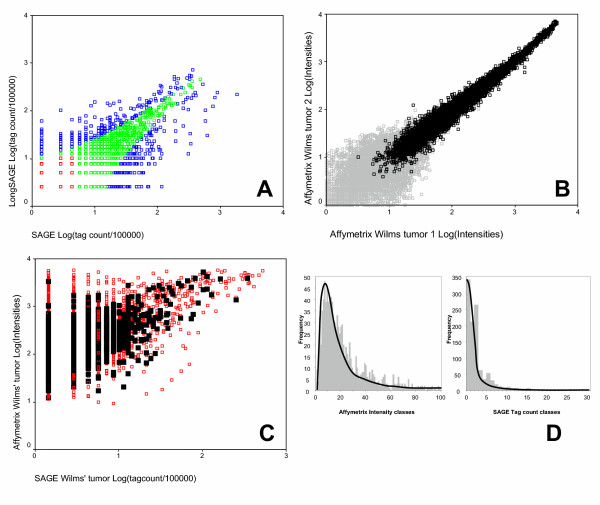
Evaluation of gene expression in Wilms' tumor tissue. The comparison of SAGE and Affymetrix duplicate samples demonstrates the reproducibility in both platforms (A, B). In addition, gene expression was compared between platforms (C) and showed a wide range of variation. The frequency distributions of gene expression values the final data sets do not differ from the total distributions (D). A: Comparison of a SAGE versus a LongSAGE library of the same sample Blue dots represent tag counts that are significantly different between the two libraries (according to the Z-test, Kal et al. 1999), green and red dots represent tag counts that do not differ between libraries. The red spots are tag counts that do not significantly differ from tag count 0 within the specified library (See also Table 4). B: Comparison of a duplicate analysis of one Wilms tumor sample using Affymetrix HG-U133A GeneChips. Gray spots represent probe sets that have an absent call. C: Comparison between SAGE and Affymetrix GeneChips for the Wilms' tumor sample. Red spots represent the total matching data set (n = 6408) and black spot represent the final selection (n = 1094). D: Frequency distribution of the Affymetrix intensity and SAGE tag counts from the final matched data set (1094 Unigene clusters) and the total matching data set. The smoothed line represents the distributions of the total data set in each platform. For both Affymetrix (classes with an intensity width of 10) and SAGE (classes based on tag counts) the distributions of the final data set and the total data set do not differ from each other (Chi-square values of 327 (df = 323; P = 0.412) and 104 (df = 105; P = 0.506), respectively).